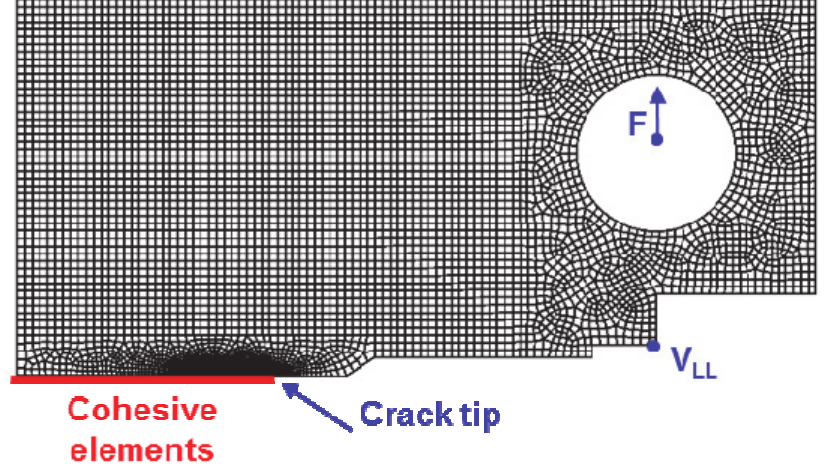
Figure 2: Scheme of the specimen and the F - V LL quantities used for the calibration